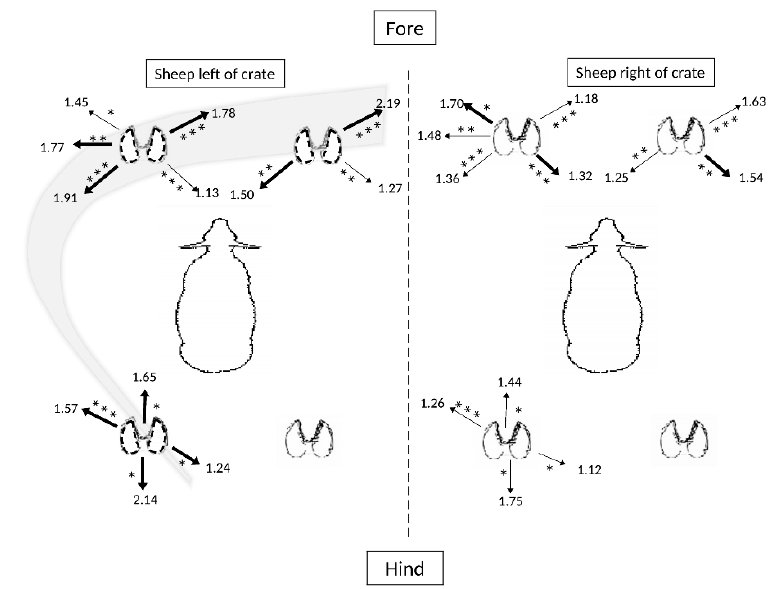
Figure 6. Effects of the side of the crate on movements (step/20 min) of the four limbs of sheep ( n = 6), with a grey arc indicating the dominant direction of movement. Significantly different frequencies in stepping direction for each respective limb are illustrated (* p < 0.05; ** p < 0.02; *** p < 0.001). Emboldened arrows represent the respectively higher counts of stepping responses for each respective direction.